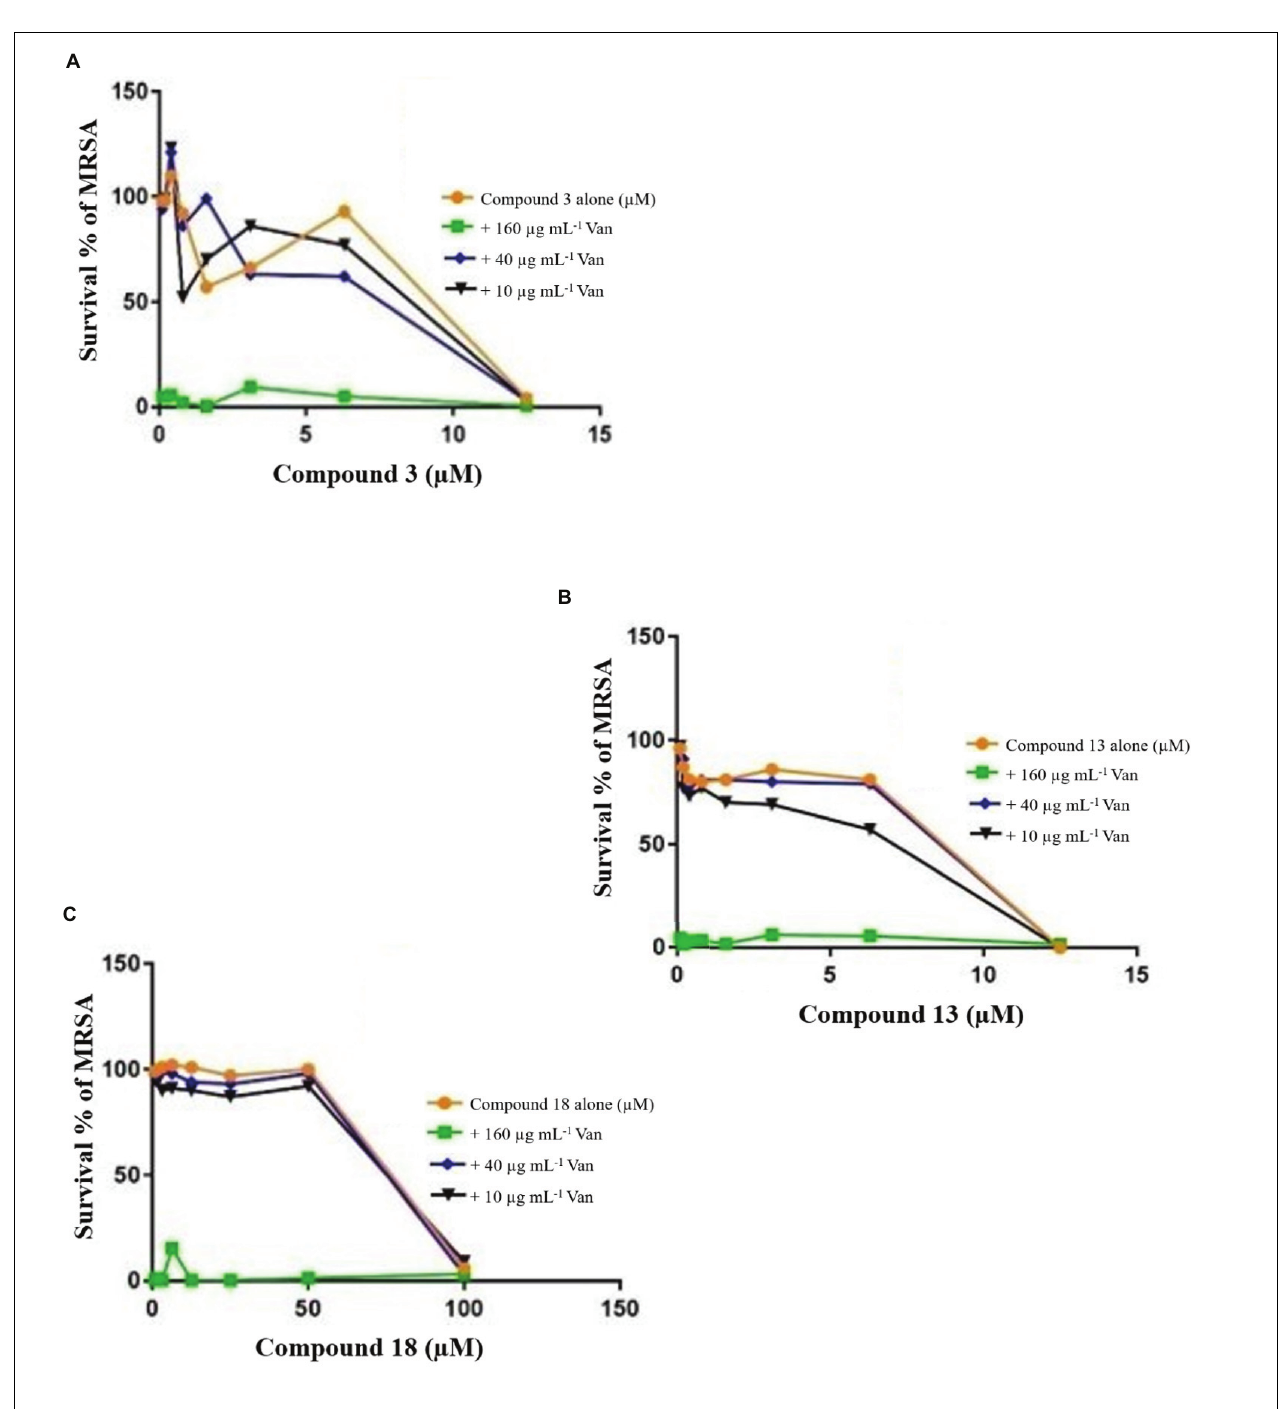
FIGURE 4 | Checkerboard study between vancomycin and 3 (A) , 13 (B) , and 18 (C) . MRSA was incubated with varying concentrations of vancomycin (Van) together with dilutions of the synthetic drugs 3 (A) , 13 (B) , and 18 (C) . Graph displays the mean survival of triplicate samples and represents data from three independent